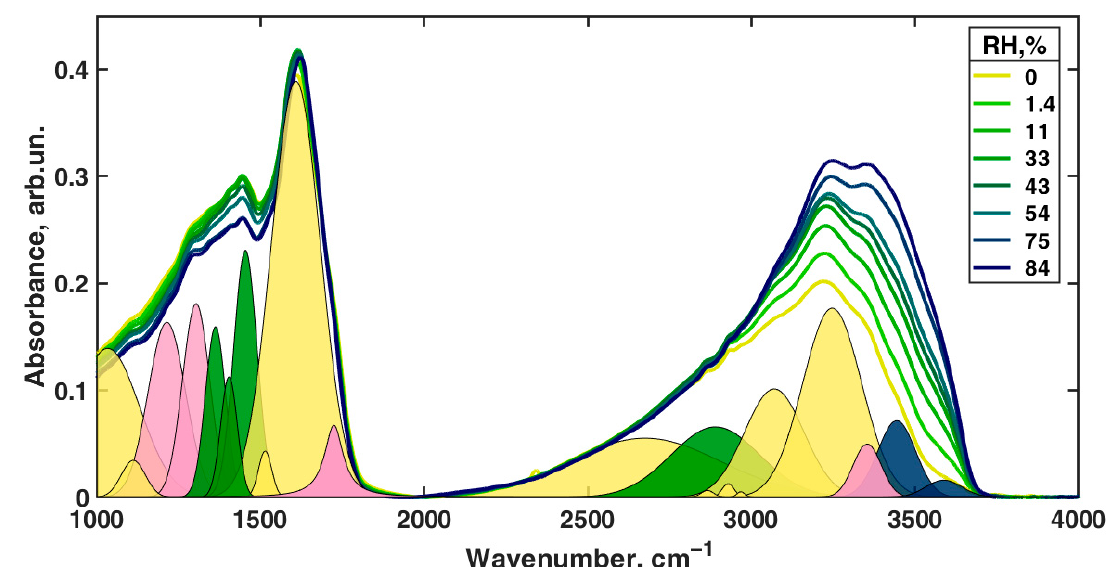
Figure 5. The solid lines are the measured infrared spectra of the synthetic melanin thin film at 25 ° С for various hydration levels from 0% RH to 84% RH (see the legend). The colored peak areas result from the 0% RH spectra deconvolution into an appropriate set of well-known peaks. The pink areas include lines associated with the carbonyl vibrations; the two blue peaks are assigned to water-connected vibrations; green areas include vibrations of semiquinone and the remainder; yellow peaks refer to the excitations of the melanin. See the main text for the assignments.